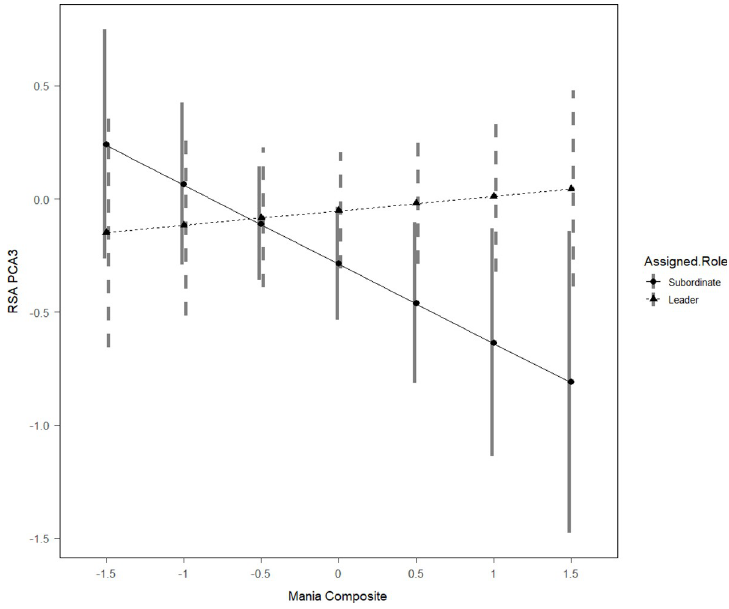
Fig 3. Interaction between assigned role and mania risk predicts respiratory sinus